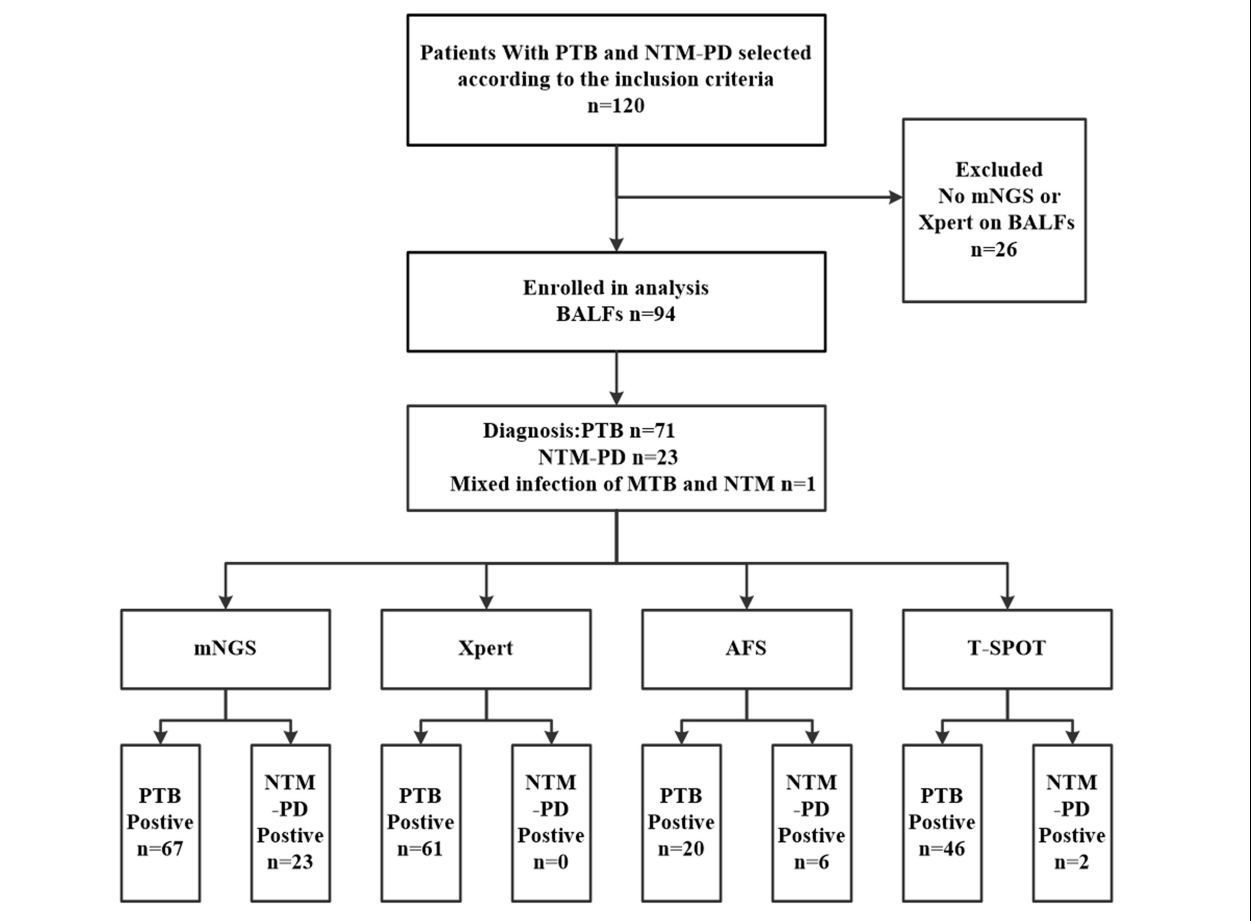
FIGURE 1 | Technology